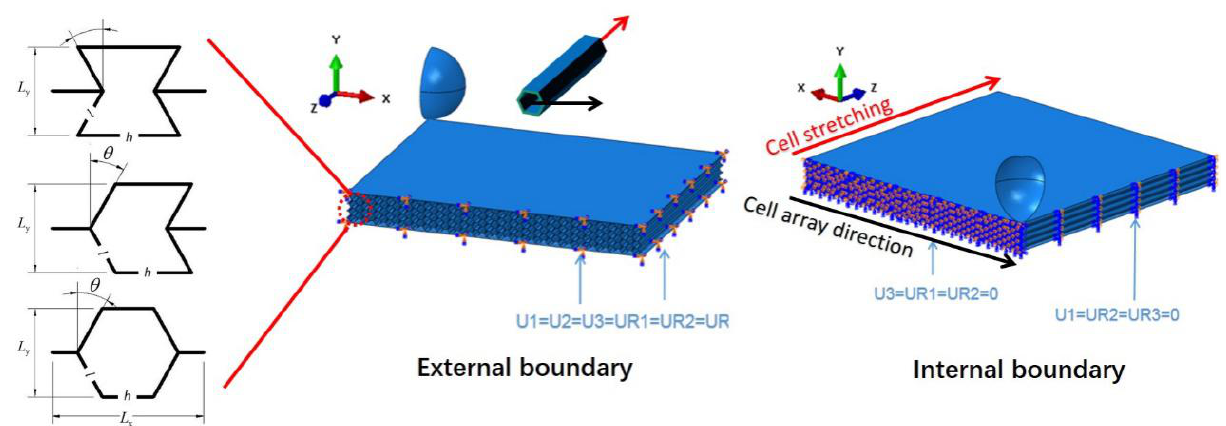
Figure 6: FE model of Sandwich panels with different in-plane honeycombs (re-entrant, semi-re-entrant, convex). Table 2: Geometrics of honeycomb cores with different Poisson’s ratio.